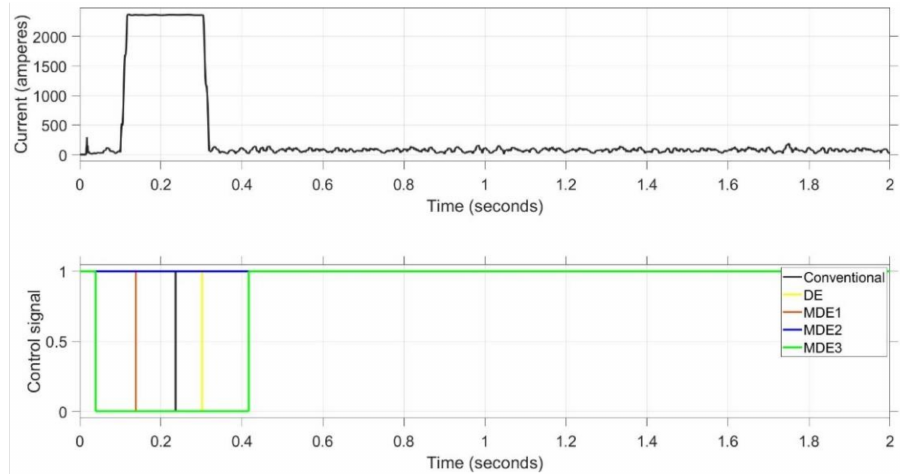
Figure 8. Fault clearance with conventional and optimum settings for a rising voltage